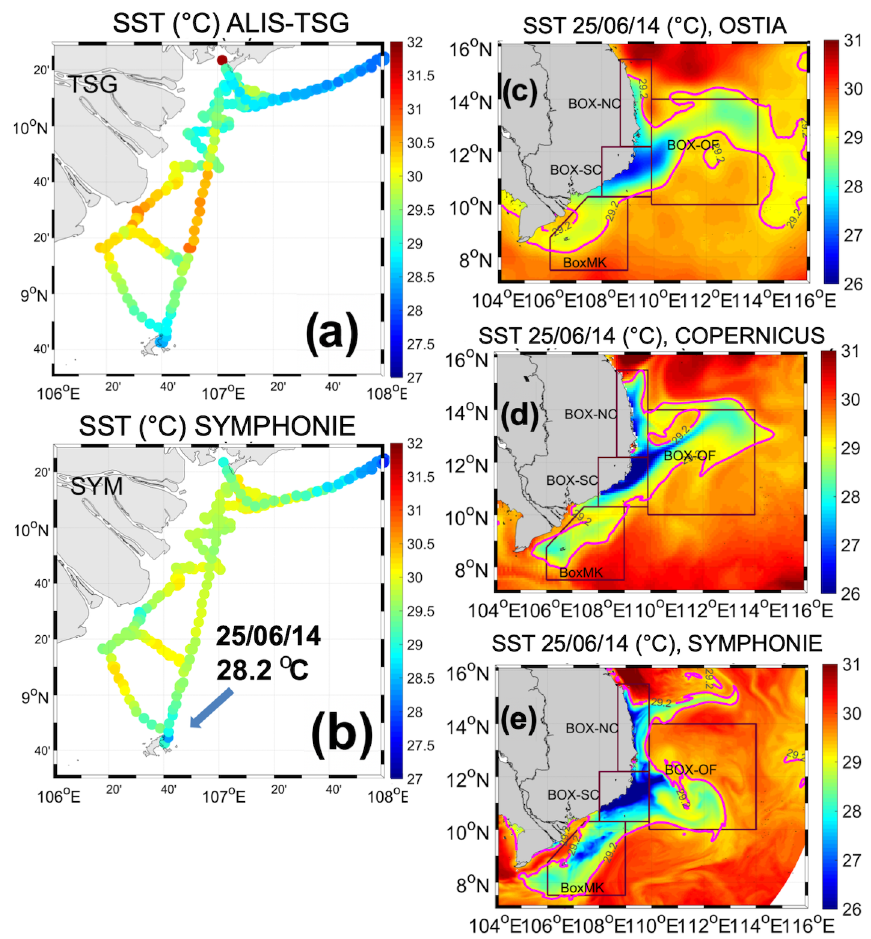
Figure 4. Simulated (SYMPHONIE, a ) and observed (ALIS-TSG, b ) SST ( ◦ C) during the R/V ALIS trajectory offshore of the Mekong mouth in June 2014. The arrow shows the location of minimum SST ( ∼ 28.2 ◦ C both in data and model) recorded near Con Dao islands ( ∼ 8.6–106.6 ◦ E) on 25 June 2014. SST on 25 June 2015 ( ◦ C) in OSTIA (c) , COPERNICUS (d) , and SYMPHONIE (e) . The pink contour shows the isotherm T ref = 29.2 ◦